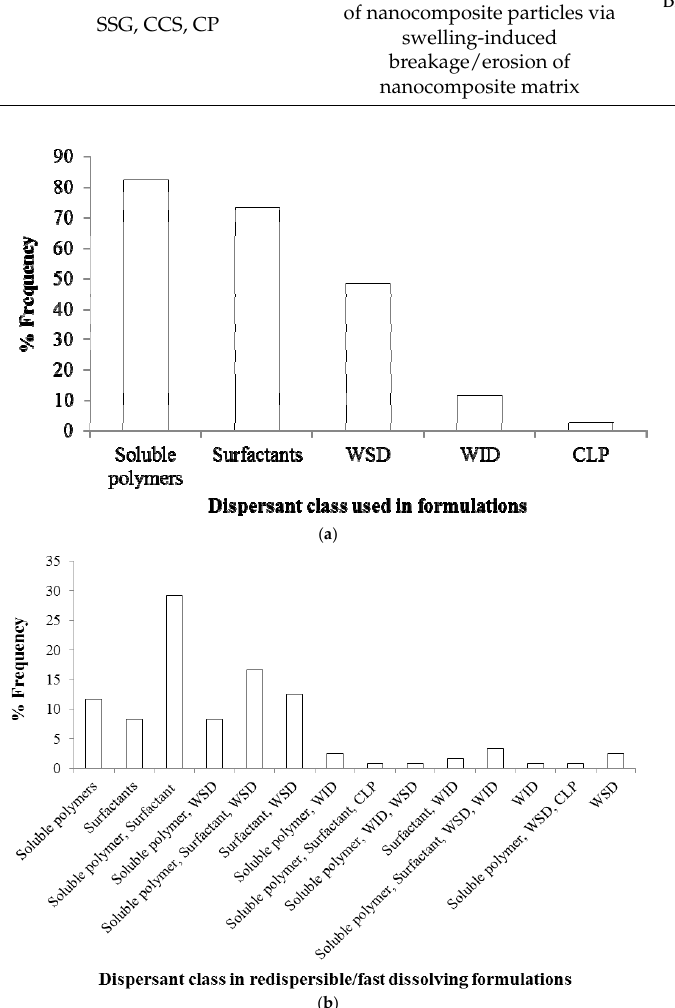
Figure 8. The usage frequency of ( a ) various classes of dispersants and ( b ) classes of dispersants in the formulations that led to formation of redispersible nanocomposites in the studies reported in Table 2. The sample size for the analysis here is 120, even though the number of publications in Table 2 is 92, because some studies investigated more than one drug. WSD: other